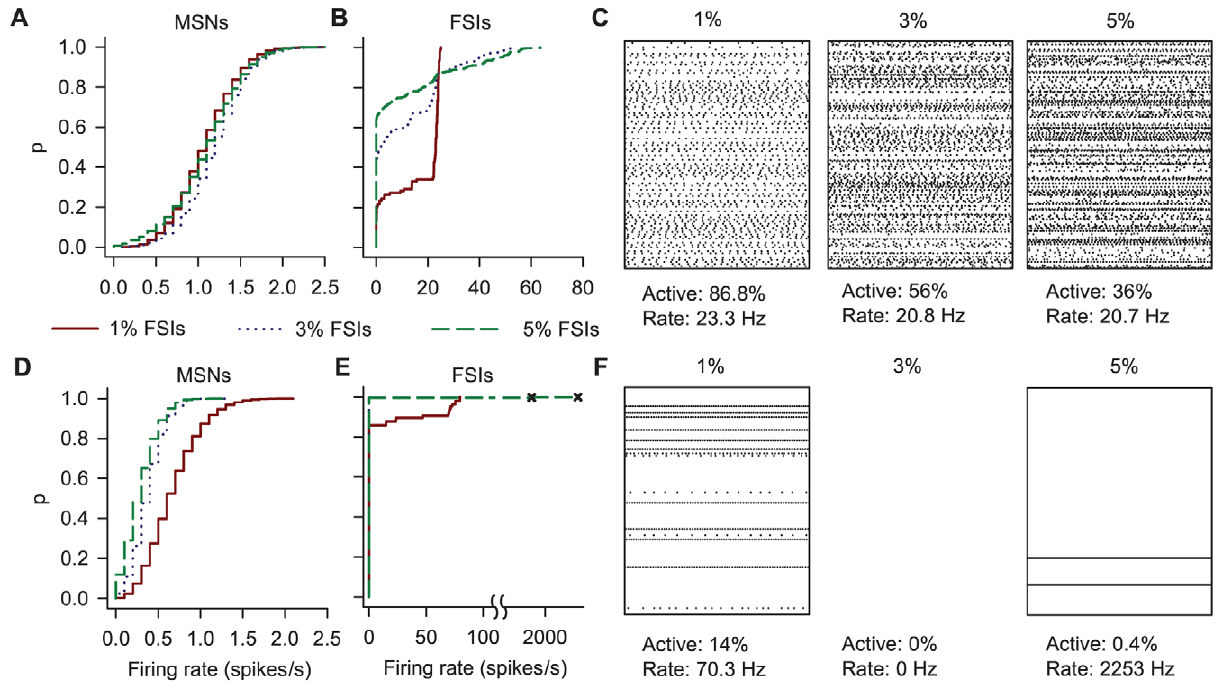
Figure 9. Effects on simulated striatal activity of changing the spatial scales of the inter-FSI synaptic and gap junction networks. We ran simulations of a 500 m m -on-the-side cube of striatum (giving 10613 MSNs) for each FSI density (giving 106, 318, and 531 FSIs respectively); each neuron was driven for 10 simulated seconds by background cortical input of around 475 spikes/s – just above the threshold for causing a MSN to spike [80]. To investigate the effects of the spatial scales of inter-FSI connections, we ran two sets of simulations: one set (panels A–C) using networks built with the expected intersection functions reported here (equation 20 and Table 4); the other set (panels D–F) using networks built the same way except that the FSI-FSI gap junction and synaptic functions were swapped – thus inverting the spatial relationships between the inter-FSI gap junction and synaptic networks. A The resulting empirical cumulative distribution functions (ECDFs) of MSN firing rates for each density of FSIs when using the normal anatomical model. The distribution of MSN firing rates remained largely the same with increasing FSI density, and the model MSNs had very low firing rates, characteristic of MSN activity in vivo . B The resulting ECDFs of FSI firing rates from the same simulations, showing that increasing the density of FSIs increased the proportion of silent FSIs, but also broadened the distribution of firing rates. C Raster plots of 1 s of activity of all FSIs in each simulation, illustrating these changes in firing rate distribution: the figures given below each raster show how the median firing rate of the active FSIs remained relatively consistent, even though firing rate distributions broadened, and the proportion of active FSIs fell. D The ECDFs of MSN firing rates after swapping the FSI connection functions shows that the MSN firing rate distribution was no longer constant; indeed for 3% FSIs the distribution was that of an MSN-only model, as all FSIs were silent. E The corresponding ECDFs of FSI firing rates show a dramatic effect on FSI activity. For 1% FSIs, swapping the connection functions caused an increased proportion of silent FSIs, but with a broadened spread of rates compared to the normal model; the 3% FSI network was completely silent. The 5% FSI network entered a pathological state where only two FSIs fired at extreme rates (indicated by the two crosses). F These changes in FSI firing rate distribution are clear in the corresponding 1 s raster plots.